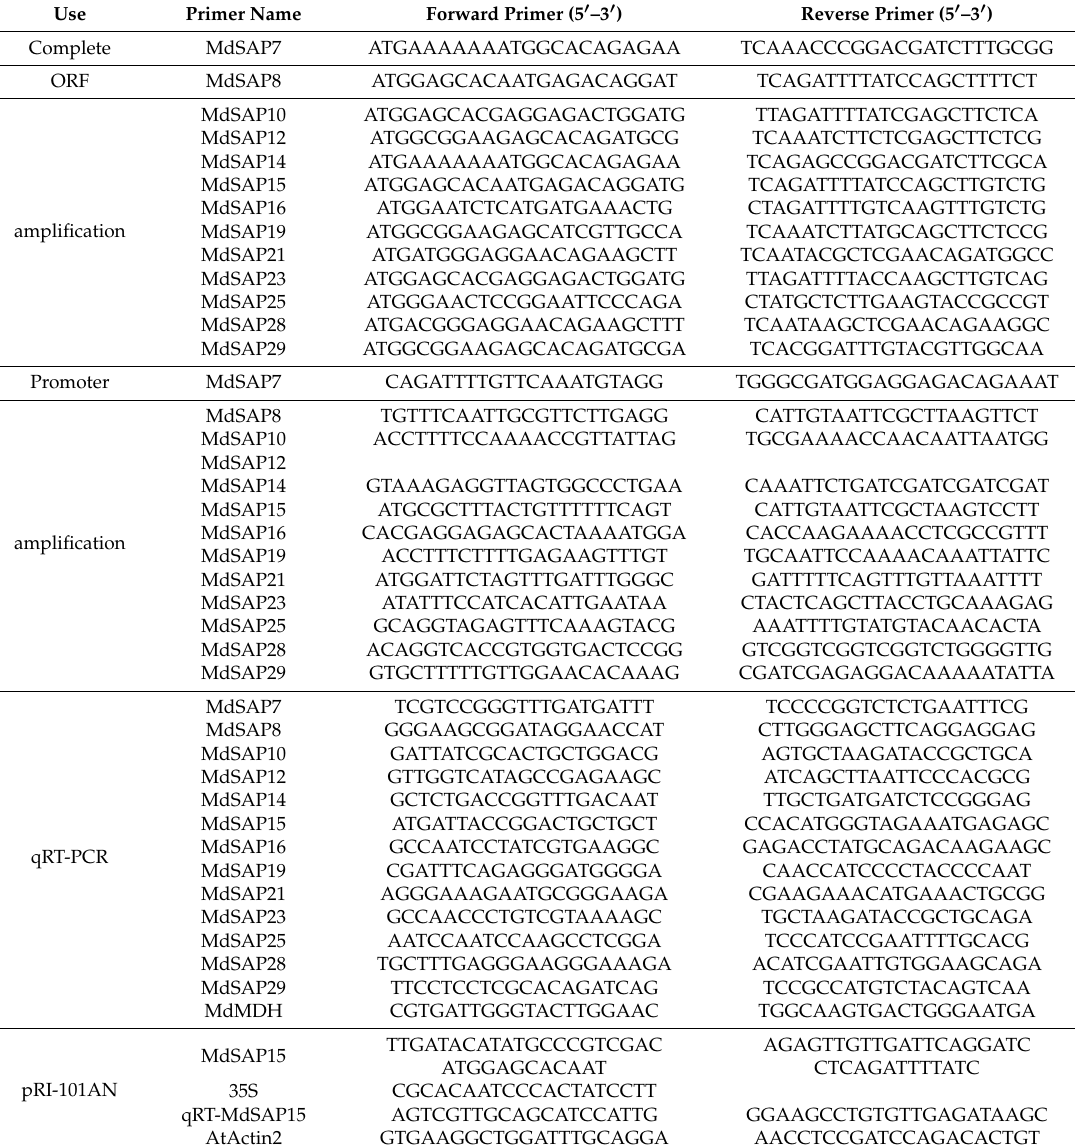
Table 5. Application of primers and sequences. ORF: open reading